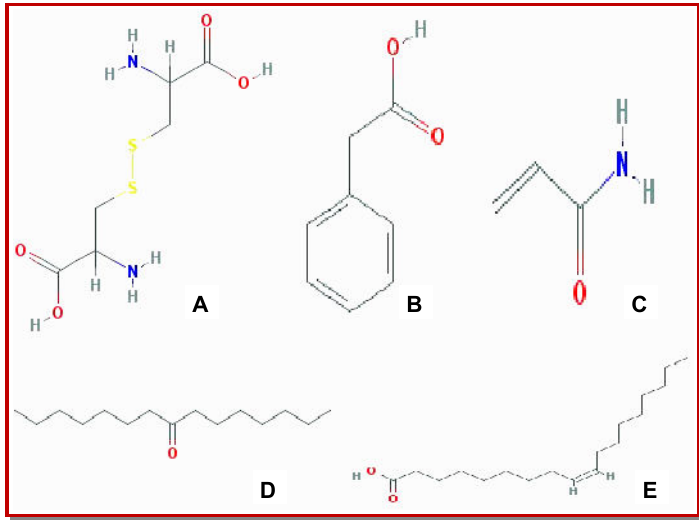
D Figure 3: 2D structure of phytocompounds of R.mucronata (A) cystine (B) phenyl acetic acid (C) acrylamide (D) caprylone (E) oleic acid. The structure retrieved from PubChem database A B